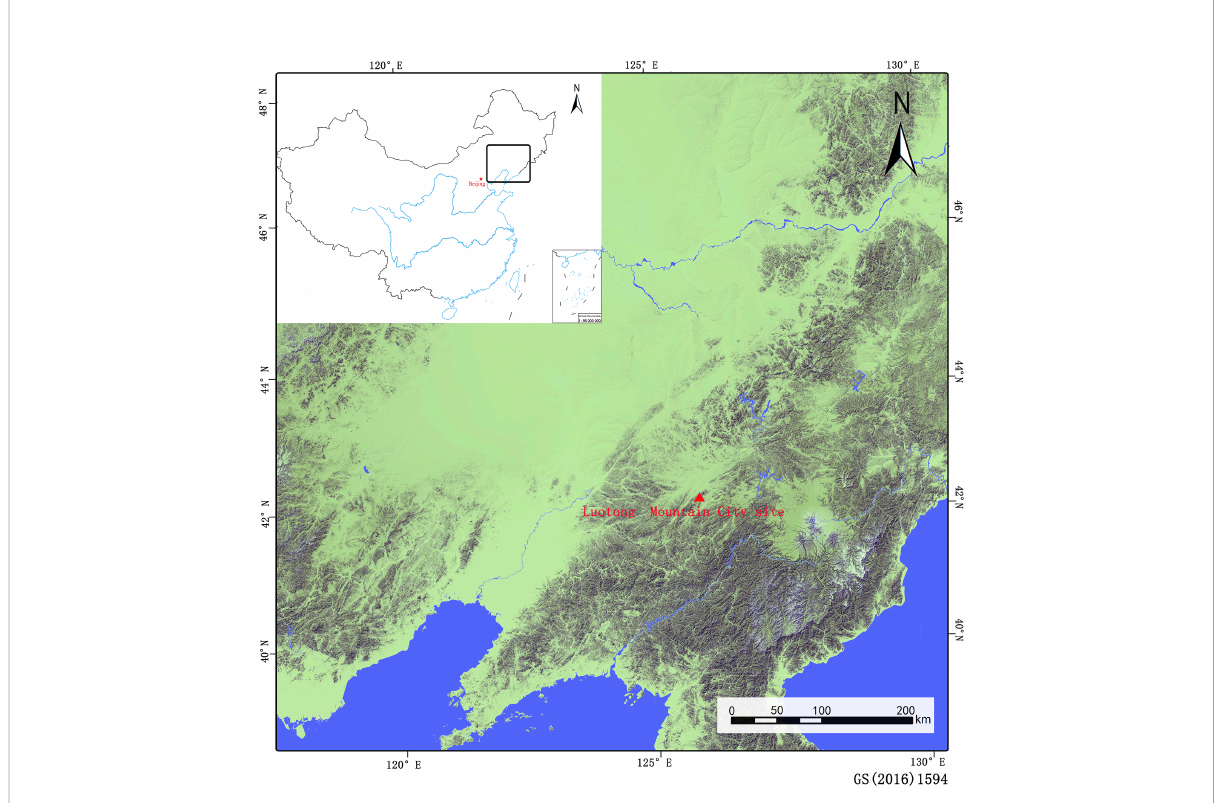
FIGURE 1 Location of the Loutong Mountain City site (Original Image Source: http://bzdt.ch.mnr.gov.cn and